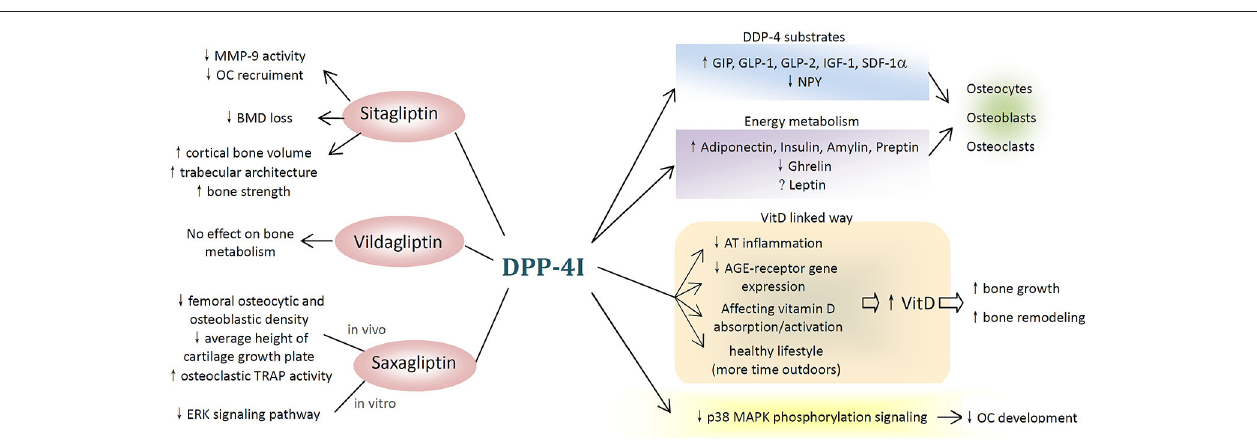
FIGURE 1 | Potential mechanisms of dipeptidyl peptidase-4 inhibitor (DPP-4I) on bone metabolism. (1) Different types of DPP-4Is affect bone metabolism differently. Sitagliptin have beneficial effects on bone resorption, bone mineral density, and bone quality, while vildagliptin shows no effect and saxagliptin negatively affects bone metabolism both in vivo and in vitro . (2) DPP-4Is attenuate the negative effects of hyperglycemia on the bone. (3) DPP-4Is affect bone cells and bone markers through DPP-4 substrates and DPP-4-related energy metabolism. (4) DPP-4 exerts inhibitory effects on bone metabolism through vitamin D-linked pathway. (5) Other possible pathways (MMP-9, matrix metallopeptidase-9; OC, osteoclast; BMD, bone mineral density; TRAP, tartrate-resistant acid phosphatase; ERK, extracellular signal-regulated kinase; GIP, gastric inhibitory polypeptide; GLP, glucagon-like peptide; SDF-1 α , stromal cell-derived factor-1 alpha; NPY, neuropeptide Y; VitD, vitamin D; AT, adipose tissue; AGE, advanced glycation end products; p38 MAPK, p38 mitogen-activated protein kinase).